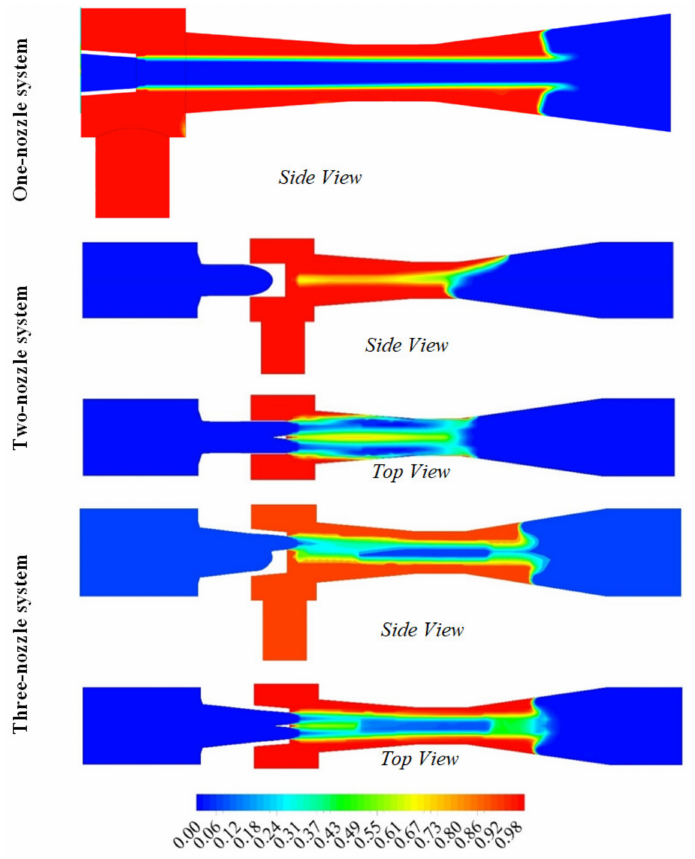
Figure 16. Vapor volume fraction along with eductor for one-, two- and three-nozzle